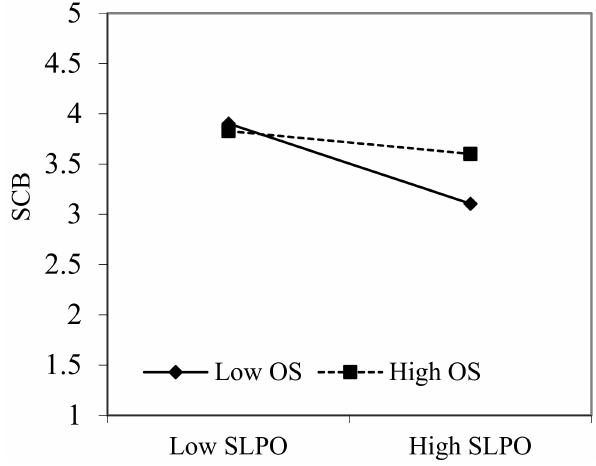
Figure 4. The interaction effect of SLPO and OS on SCB. Note: SLPO, safety-specific leader punish- ment omission, OS, organizational size and SCB, safety compliance